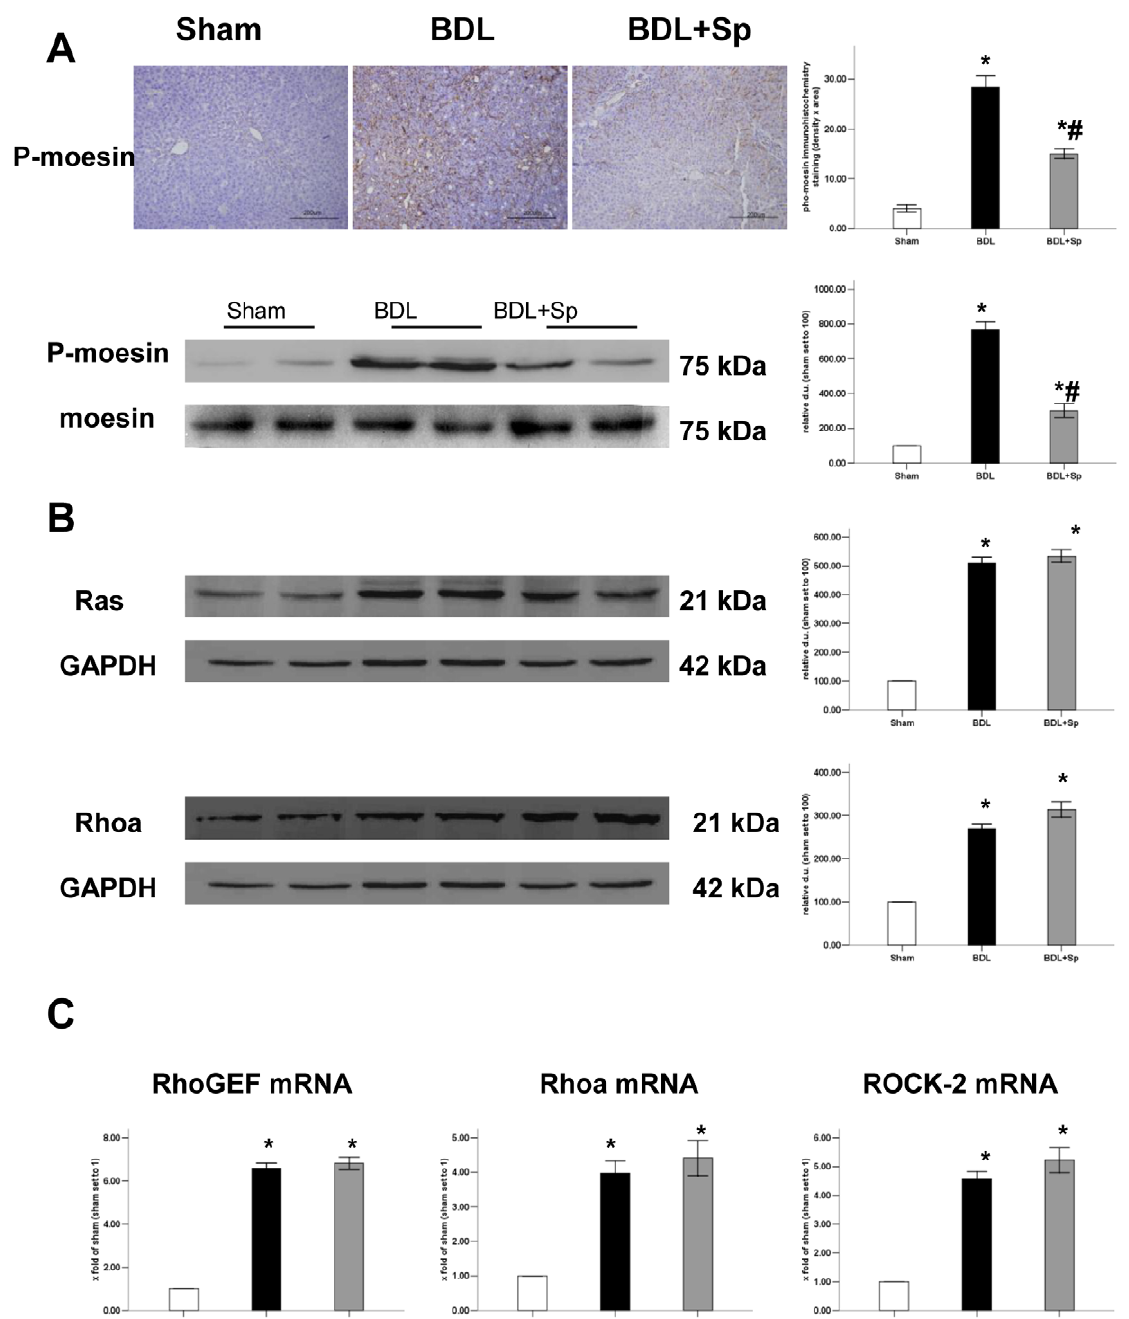
Figure 5. Sprionolactone (Sp) inhibits the phosphorylation of moesin in BDL- treated rats. (A) immunohistochemistry for hepatic phosphor-moesin of paraffin-embedded liver sections (magnification 200 6 ) and Western blot analysis of p-moe expression. (B) Expression of Ras and RhoA proteins in liver homogenates as determined by immunoblot. (C) Real-time PCR analysis for RhoGEF, RhoA and ROCK-2 mRNA expression. * p , 0.05 compared to the Sham group. # p , 0.05 compared to the BDL groups.